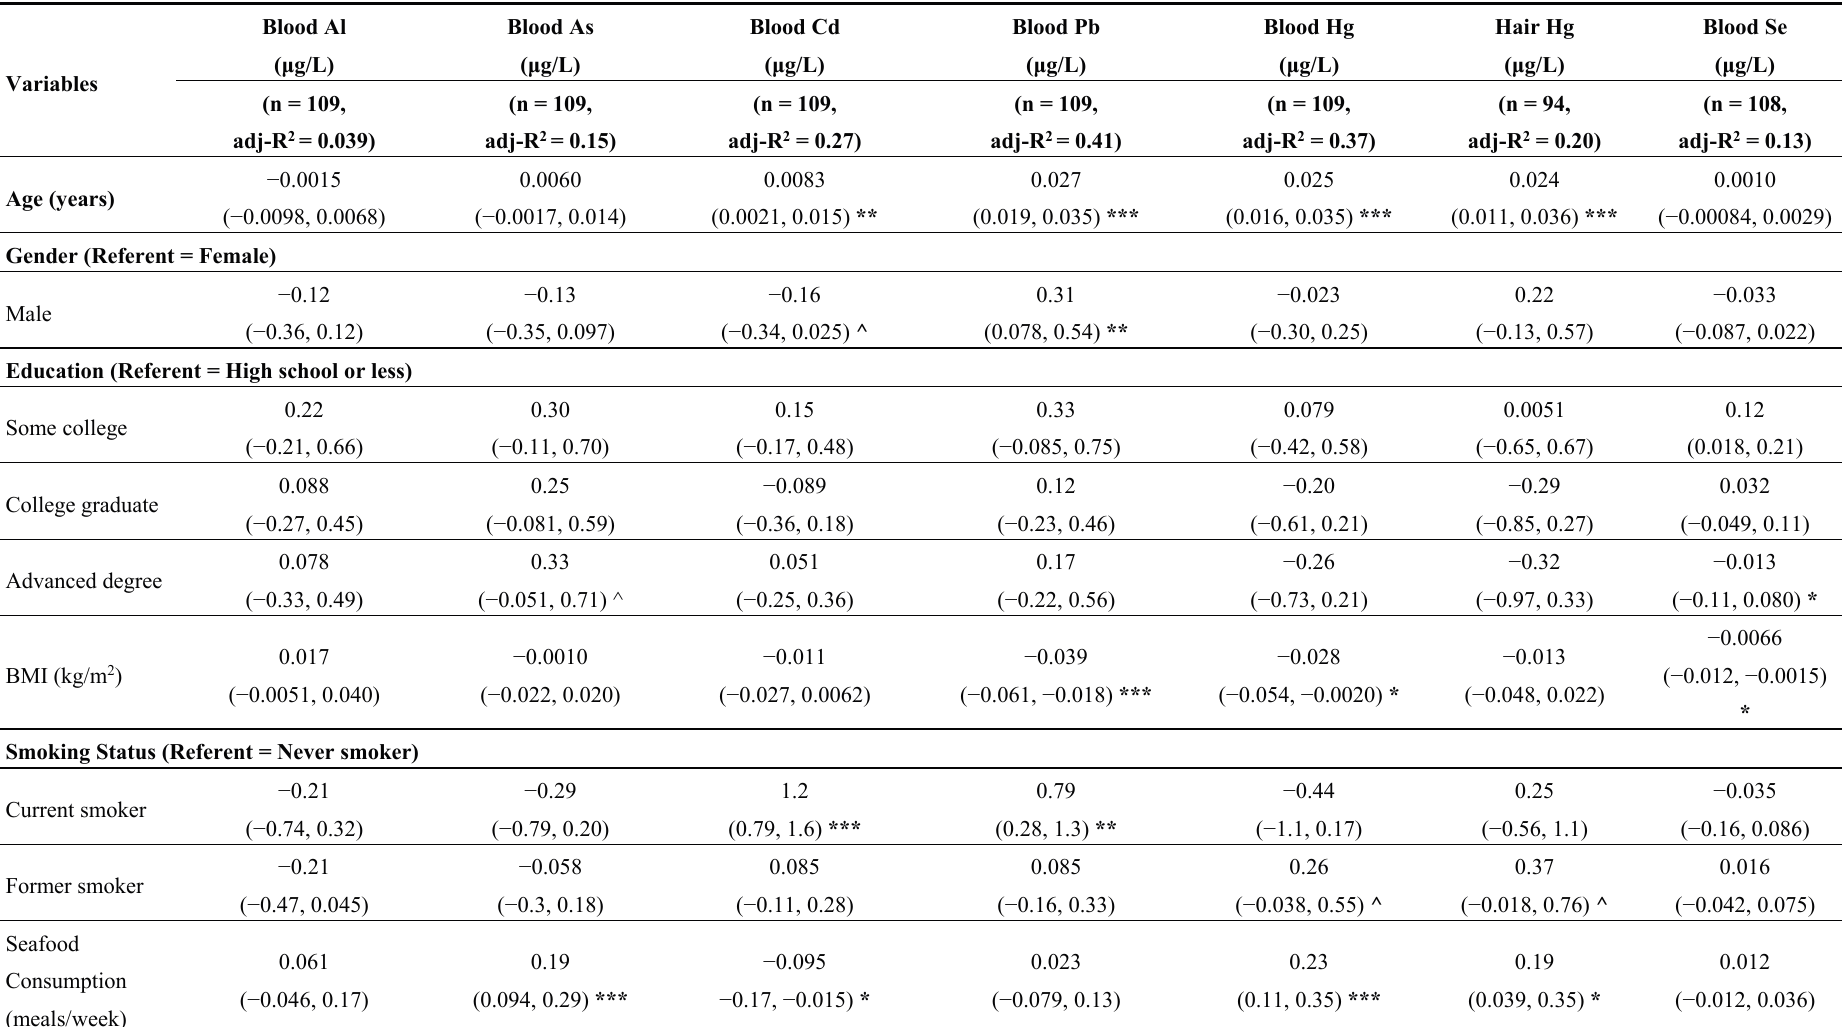
Table 4. Multivariate regression on natural log-transformed blood Al, As, Cd, Pb, Hg, Se and Hair Hg. Numbers represent model estimates, with 95% confidence intervals included in